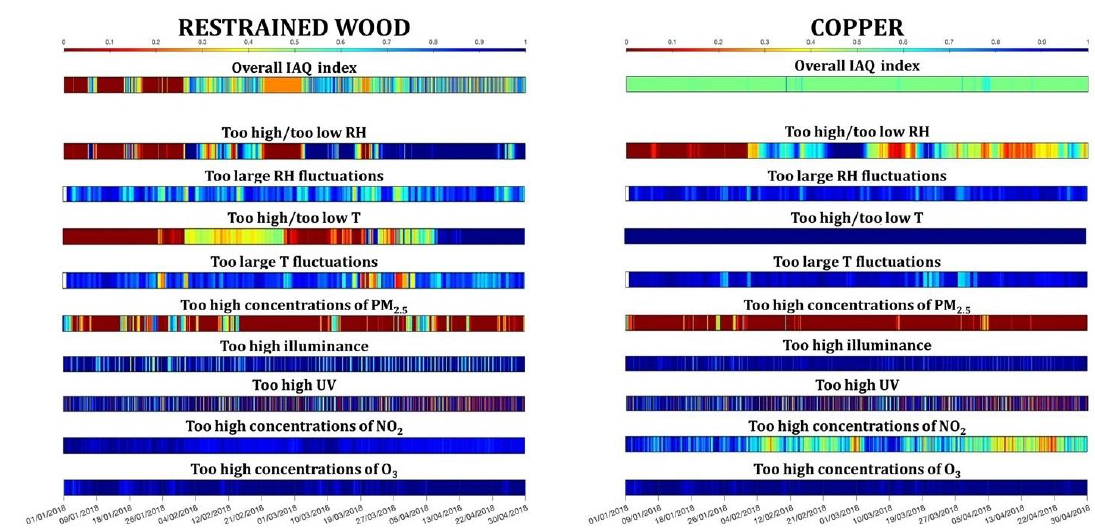
Figure 7. Overview of the parameter-specific risks for restrained wood ( left ) and copper ( right ).